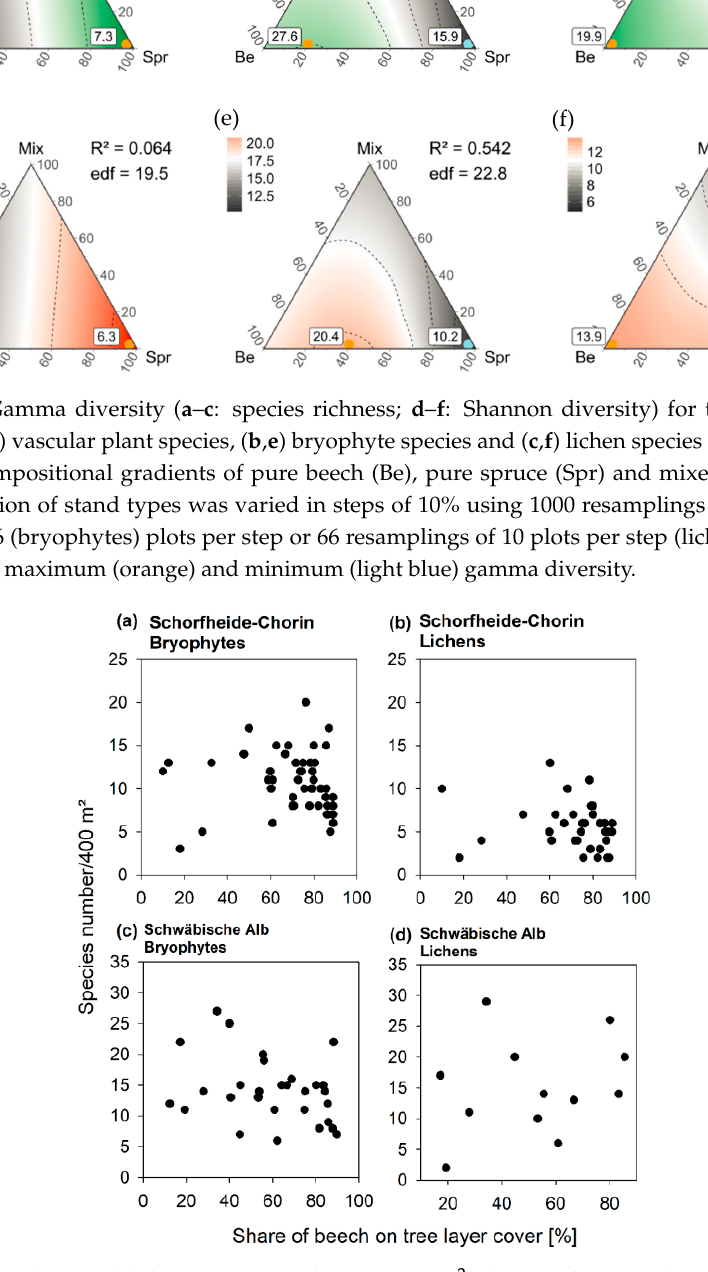
Figure A5. Bryophyte and lichen species numbers per 400 m 2 plots in relation to the percentage share of beech on tree layer cover within mixtures of ( a , b ) beech and pine in Schorfheide-Chorin and ( c,d ) beech and spruce in Schwäbische Alb. Plots were characterized as mixtures when both target species (beech and conifer) had a minimum of 10% or maximum of 90% share on accumulated tree layer cover. Note that the scale of the y-axis differs for Beech/Pine in Schorfheide-Chorin and the Beech/Spruce combination in Schwäbische